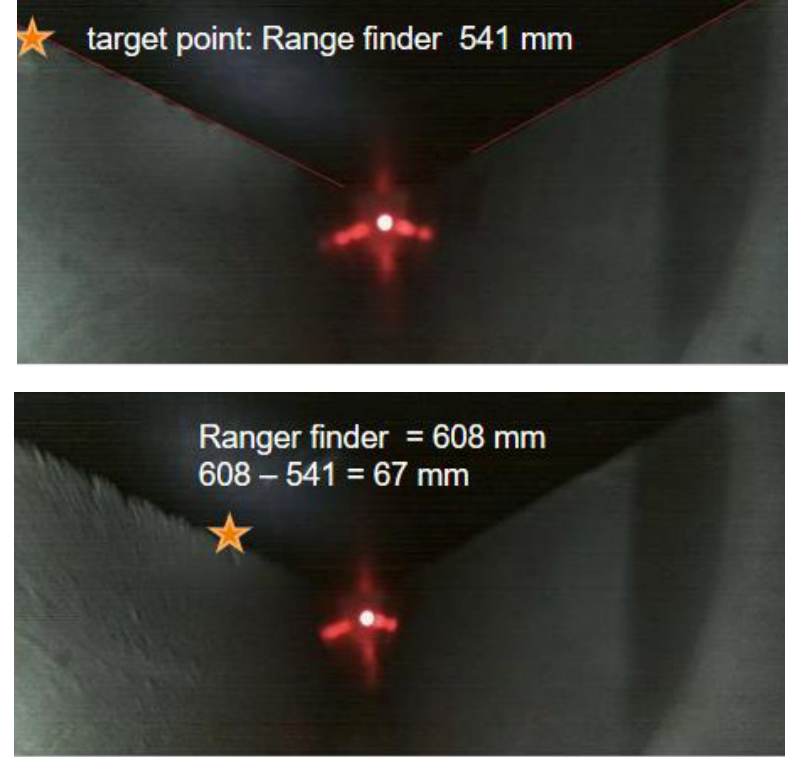
Figure 4. In the top panel, the target is selected, and calculated to be 40.99 mm from camera. In the bottom panel, the robot has moved away from the target and is calculated to be 109.63 mm from the camera.